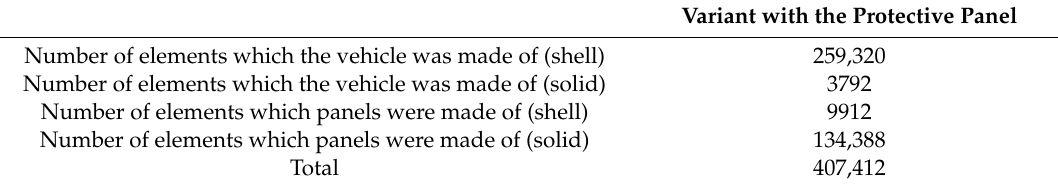
Table 1. Number of elements in numerical models. Variant with the Protective Panel